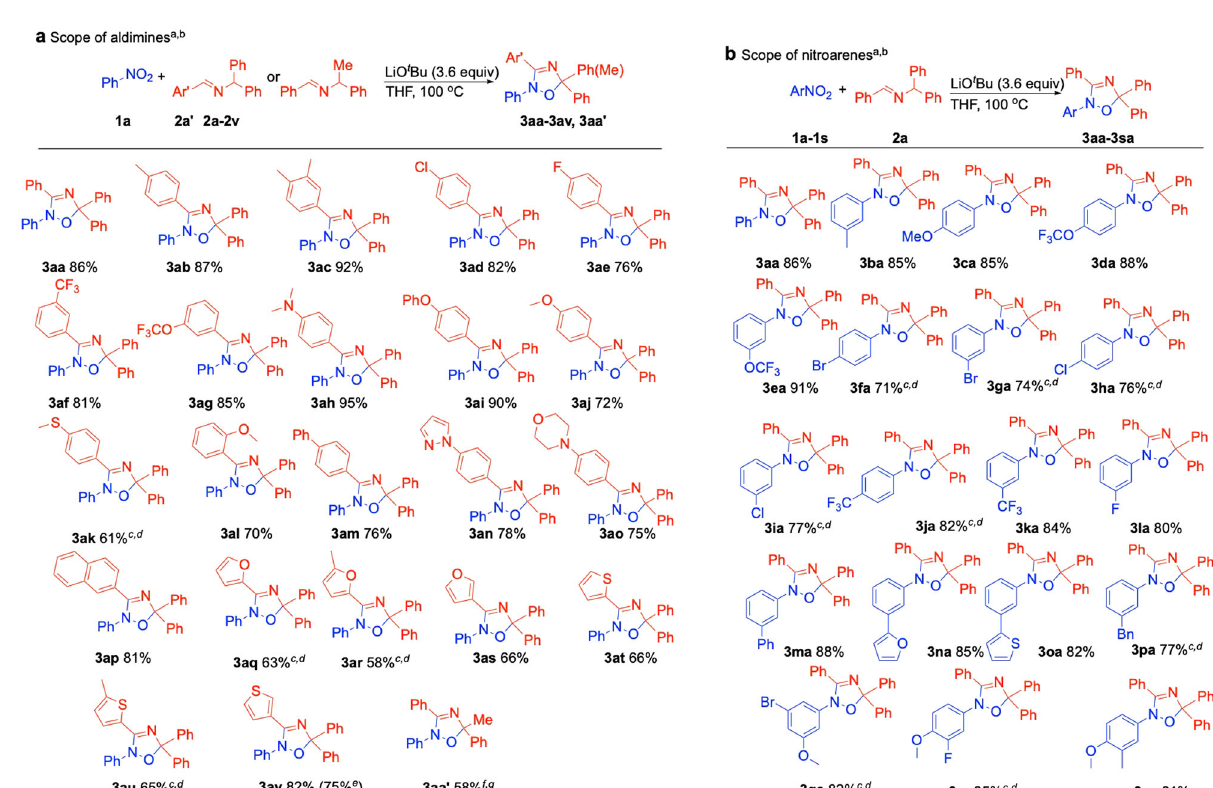
Fig. 4 Substrate scope a,b . a Scope of the aldimine. b Scope of the nitroarene. a Reaction conditions: nitroarene (0.1 mmol), aldimine (0.3 mmol), LiO t Bu (0.36 mmol), THF (0.1 M), 100 °C, 12 h. b Isolated yield. c 0.2 mmol of aldimine. d 0.24 mmol of LiO t Bu. e Reaction performed on 5 mmol scale. f 0.36 mmol of NaO t Bu. g DME (0.1